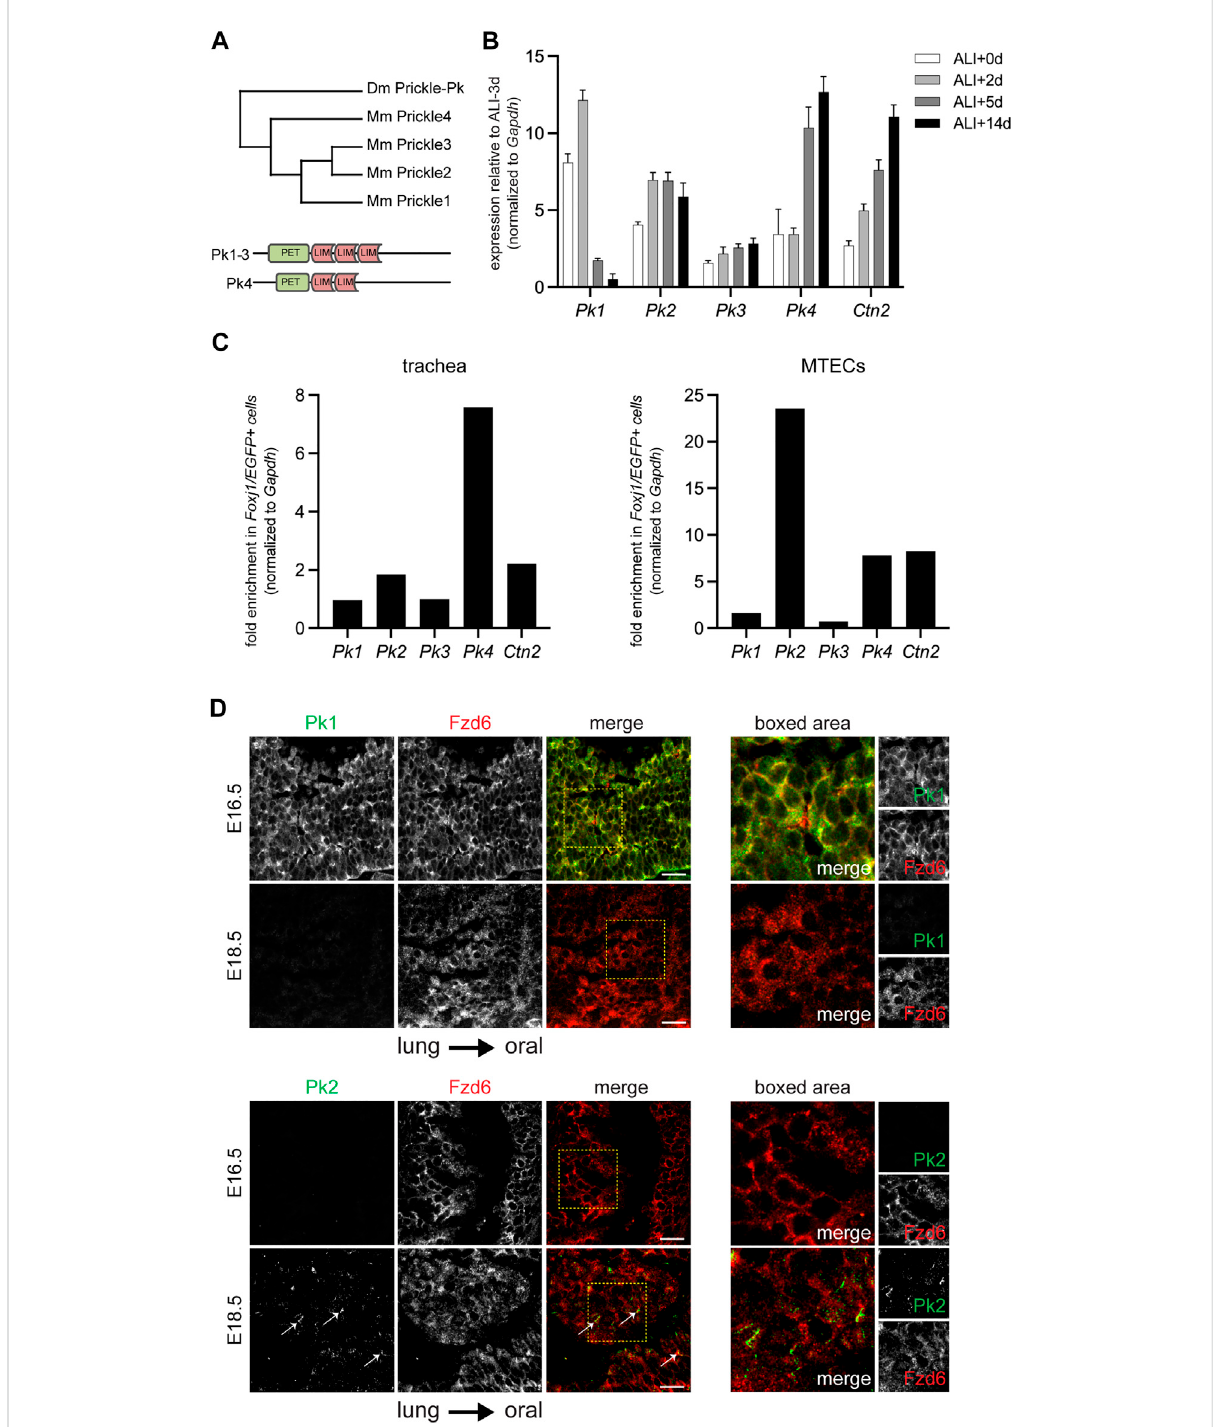
FIGURE 1 Temporal and cell type speci fi c expression of Pk family members. (A) . Phylogram depicting the mouse and Drosophila Pk proteins with schematic of domain structures of mouse Pk1-4. (B) . qRT-PCR of mouse Pk1-4 over a timecourse MTEC culture spanning early epithelialization (ALI+0-2 days), ciliogenesis (ALI+5 days), and maturity (ALI+14 days). Graph shows the average ± SE of n = 4 timecourses. The expression of Centrin2 ( Ctn2 ), a component of ciliary basal bodies is used to monitor ciliogenesis kinetics. (C) . qRT-PCR of mouse Pk1-4 expression in multiciliated ( Foxj1/EGFP positive) cells vs. other epithelial cells in the adult trachea (left) and in ALI+14 days mature MTECs (right). (D) . Maximum projectionsofconfocalimagestacksofwholemountimmunolabeled E16.5andE18.5mouse embryonictracheallumenswithPk1(left)orPk2(right) antibodies (green) and Fzd6 antibody (red). Arrows show emerging Pk2 crescents at E18.5. Boxed areas shown to the right. Scale bar, 20 μ m. Note, due to tissue curvature, it was not always possible to mount the samples suf fi ciently level to capture the entire tissue layer in a single image